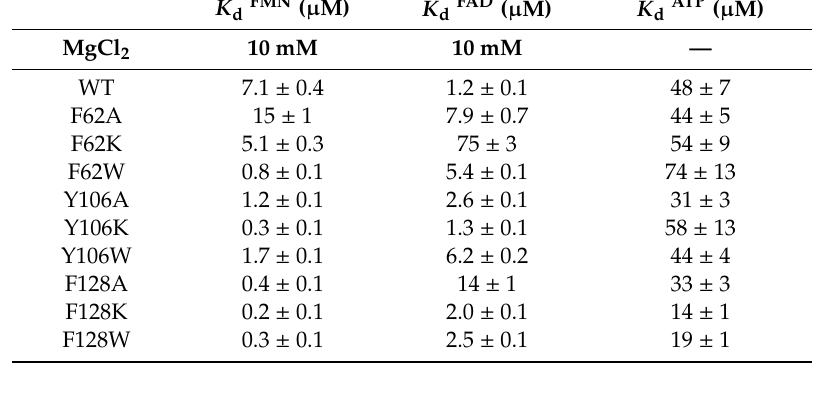
Table 3. Interaction parameters as determined for the binding of FMN, flavin adenine dinucleotide (FAD), and ATP to Ca FADS variants. Data obtained by ITC at 25 °C in PIPES 20 mM, pH 7.0, at the indicated MgCl 2 concentrations, n = 3, mean ± SD.